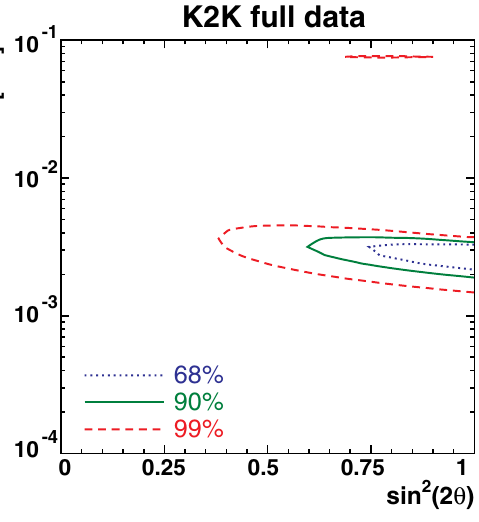
Japan: J-PARC. The name T2K comes from the initials of